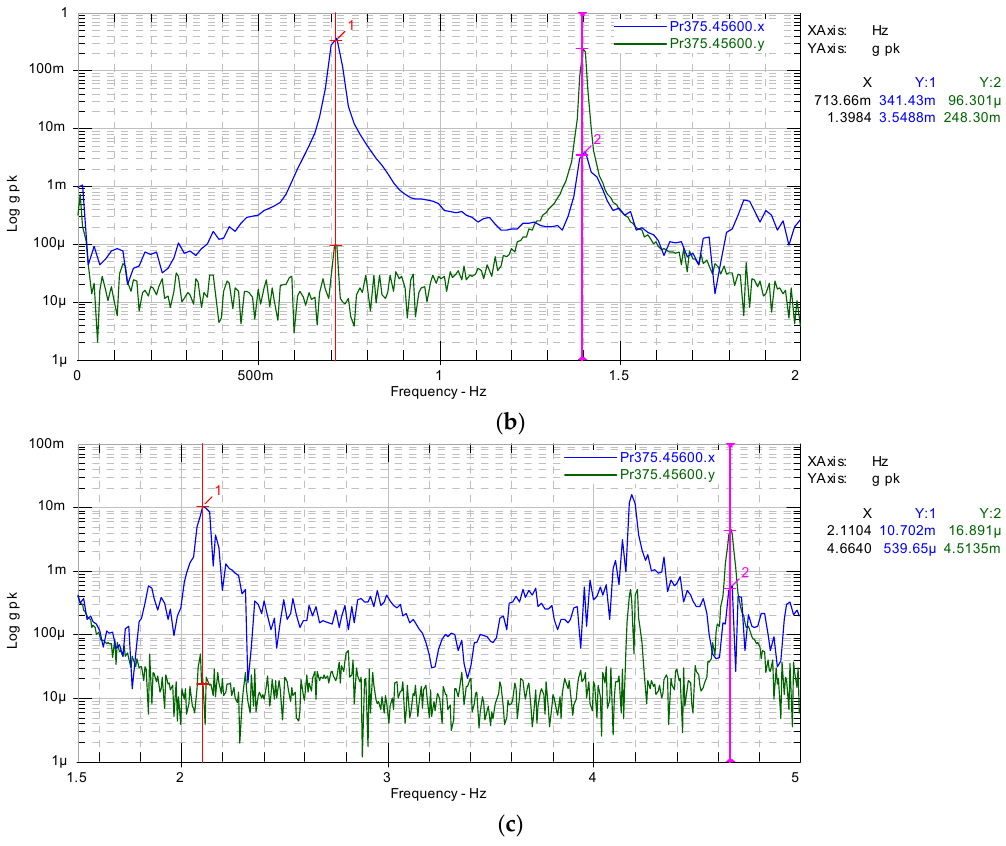
Figure 11. Frequency response function for as received blade without saddles in flapwise (blue line) and edgewise (green line) directions: ( a ) an overview; ( b ) the first modes and ( c ) the second.